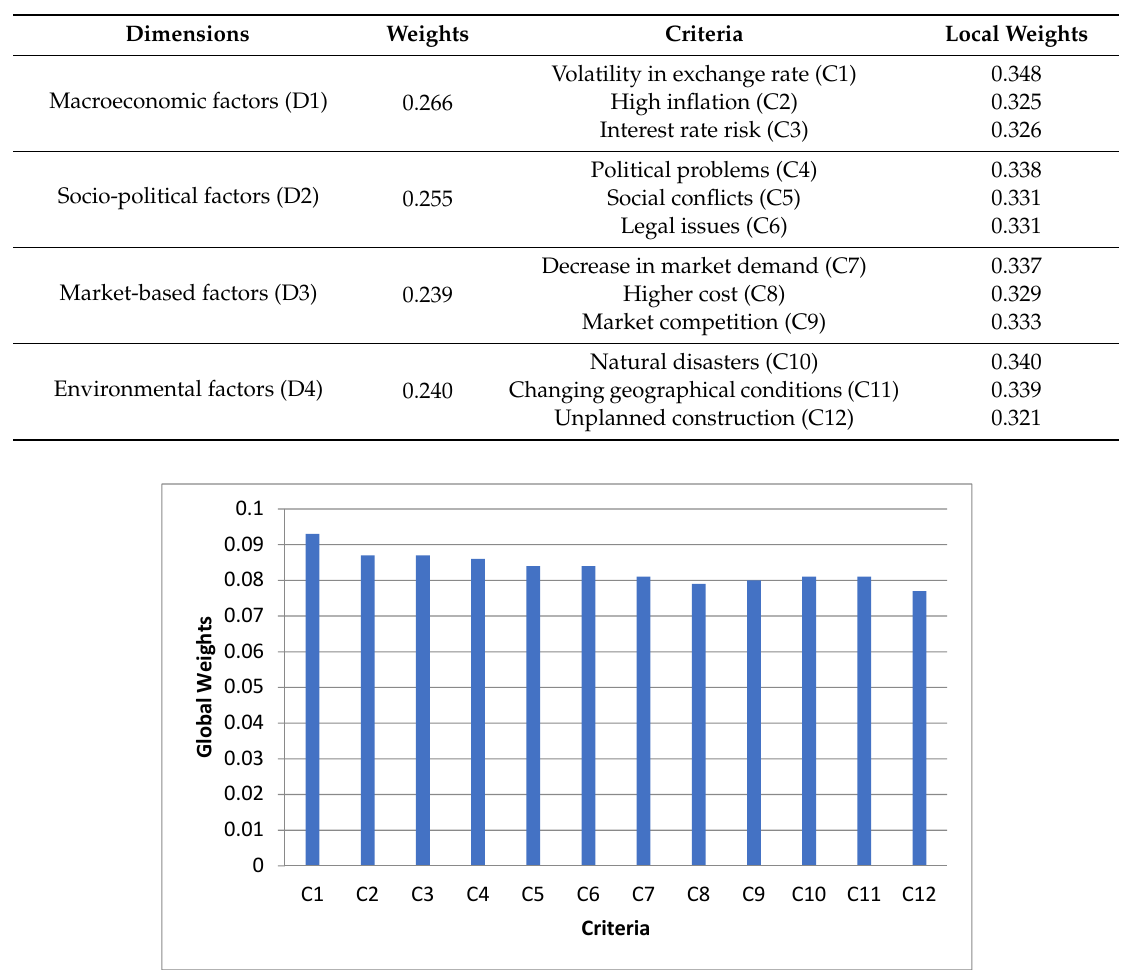
Table 7. Weights of the criteria and dimensions.